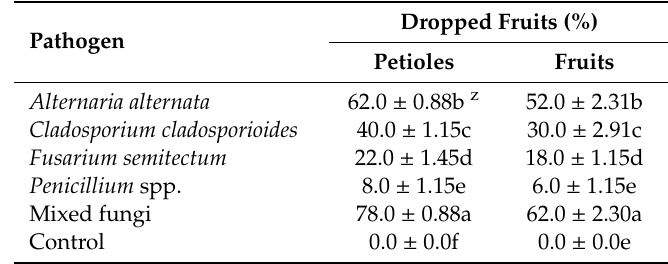
Table 3. Pathogenicity of the isolated fungi on ‘Anna’ apple petioles and fruits expressed as the percentage of dropped